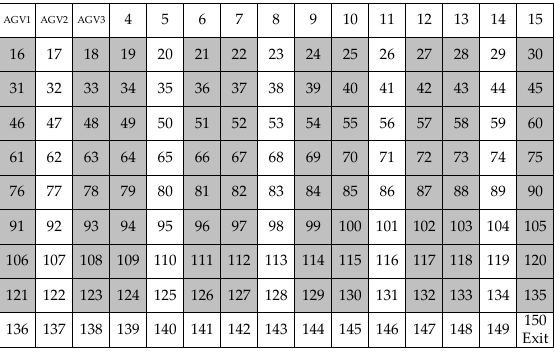
Figure 1. Plane diagram of automatic warehouse. (Take three automated guided vehicles (AGVs) as examples, and cells 1–3 are their respective entrances.).